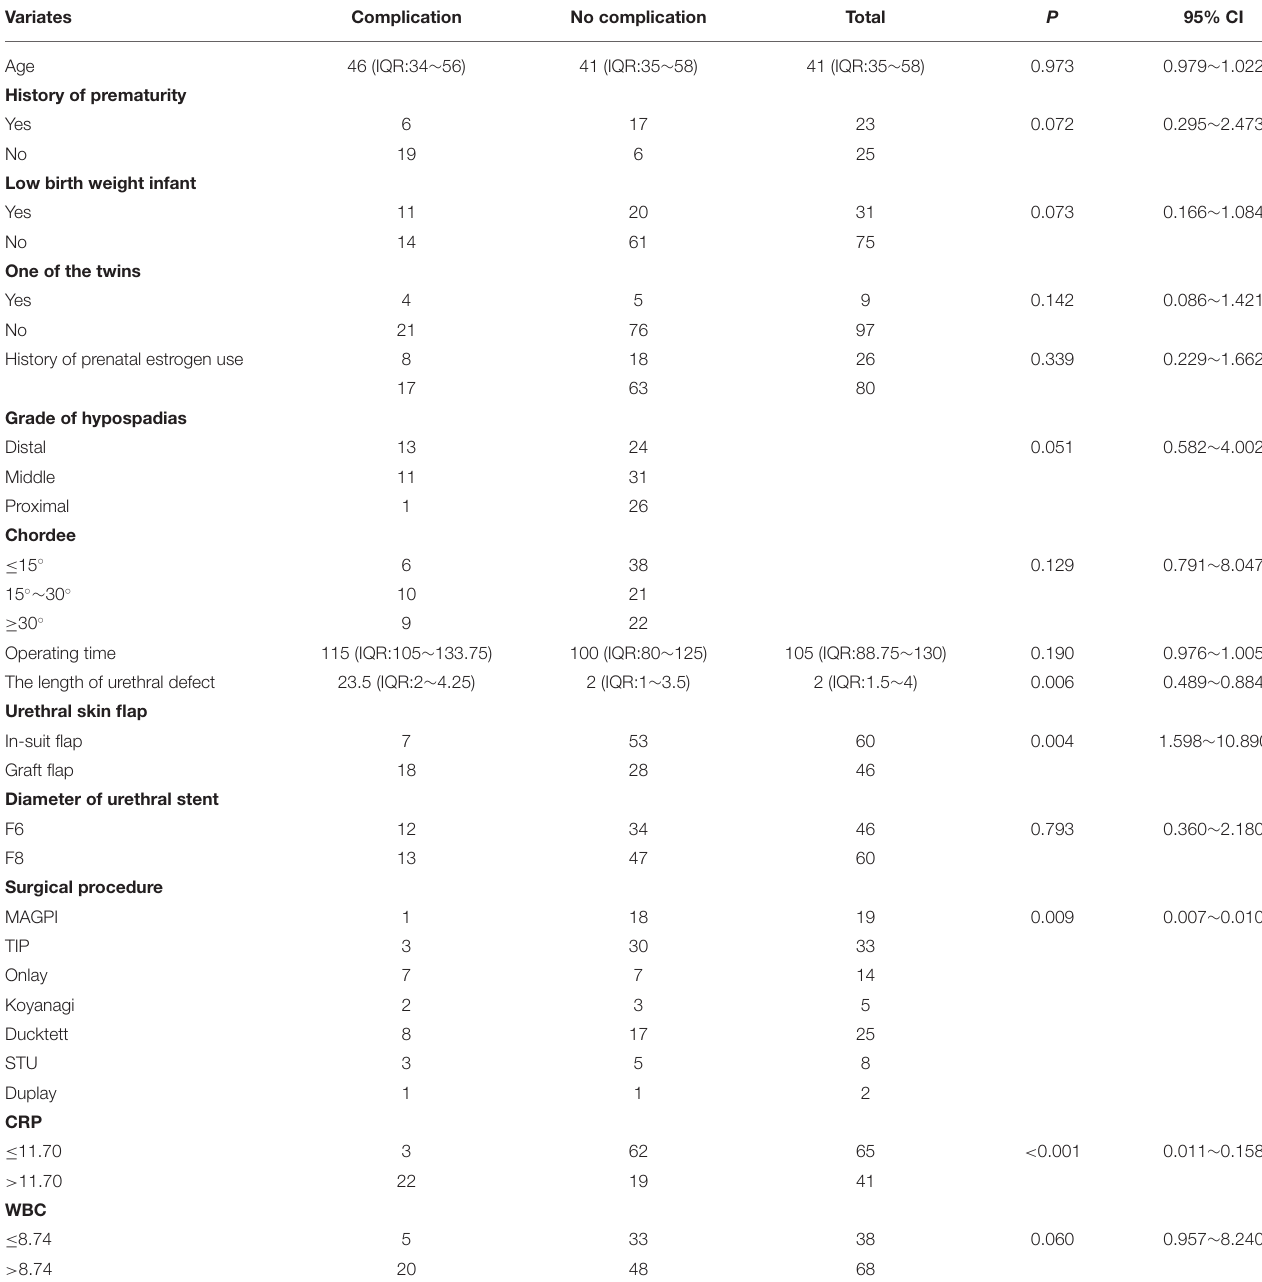
TABLE 1 | The results of binary logistic regression univariate analysis.